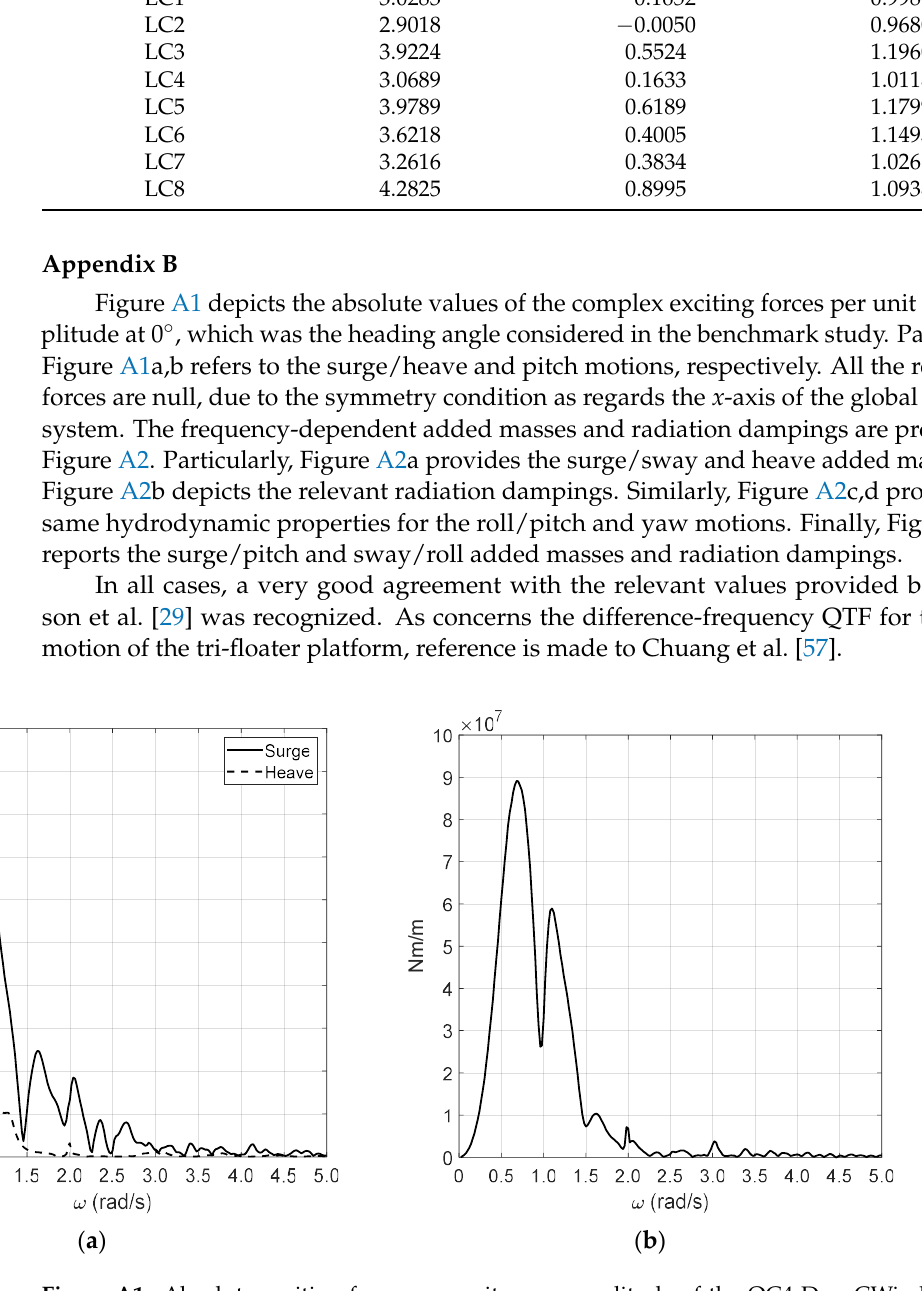
Table A1. High-order statistics of the eight stress processes. Load